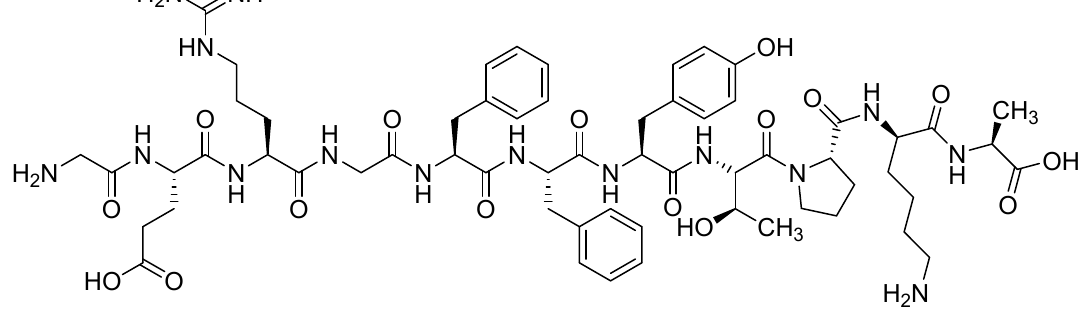
Figure 10. Schematic illustration of the chemical structure of insulin.